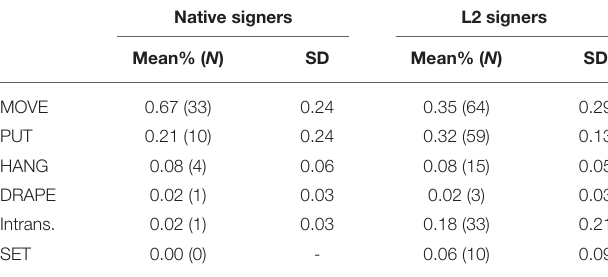
TABLE 2 | Verb types by group.